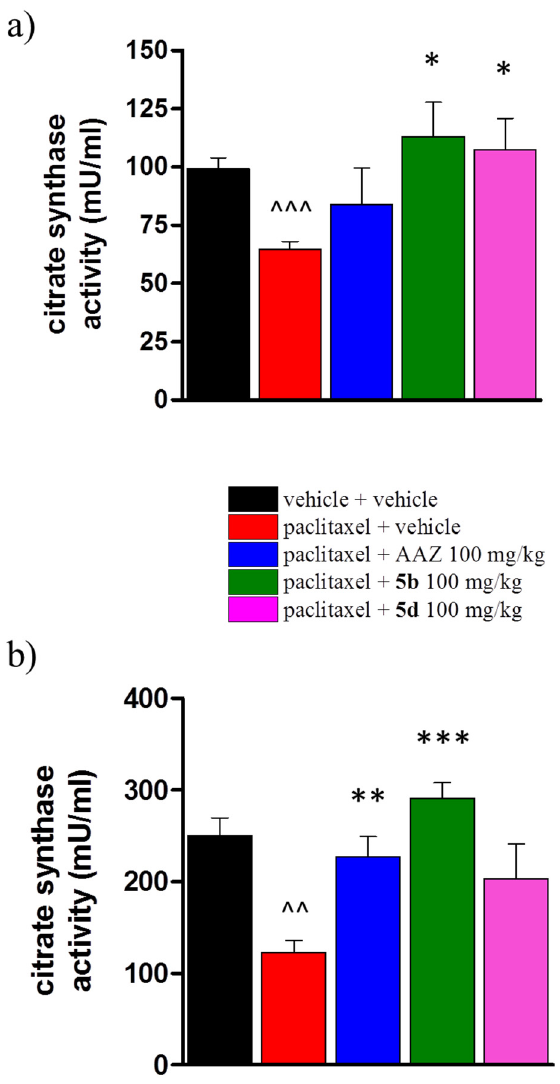
Figure 7. Histograms showing the citrate synthase (CS) activity (mU/mL) measured in mitochondria isolated from the brain ( a ) and spinal cord ( b ) of animals submitted to pharmacological treatments. Data are expressed as the mean ± S.E.M. of values from five brain and five spinal cord tissue samples per group. ^^ p <0.01 and ^^^ p < 0.001 vs. vehicle + vehicle; * p < 0.05, ** p < 0.01 and *** p < 0.001 vs. paclitaxel + vehicle.